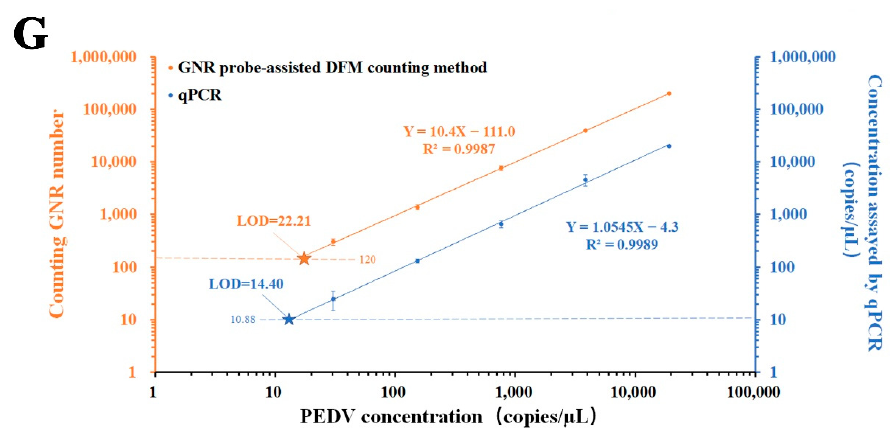
Figure 7. GNR probe-assisted DFM counting of PEDV samples. ( A ) Dark field image of sample without PEDV. ( B ) Dark field image of sample with PEDV of 3.07 × 10 1 copies/ µ L. ( C ) Dark field image of sample with PEDV of 1.53 × 10 2 copies/ µ L. ( D ) Dark field image of sample with PEDV of 7.67 × 10 2 copies/ µ L. The red squares are the green halos generated by a GNR recognized by counting software in B-D. ( E ) Dark field image of sample with PEDV of 3.83 × 10 3 copies/ µ L. ( F ) Dark field image of sample with PEDV of 1.92 × 10 4 copies/ µ L. ( G ) Calibration curves of DFM counting and qPCR. Each counting GNR number on the GNR probe-assisted counting method curve was obtained by multiplying the mean number of GNR particles from 20 DFM images of the corresponding PEDV sample on the chip by 400. The calibration curve of qPCR was plotted by the quantitative value (theoretical concentration) of RNA extracted from these PEDV samples versus the measured concentration values by the standard curve of the copy number corresponding to the concentration of the standard plasmid-CV777 (a specific gene fragment of PEDV). The pentagram is the intersection of the calibration curve with three times signal-to-noise ratio. Scale bar: 20 µ m.